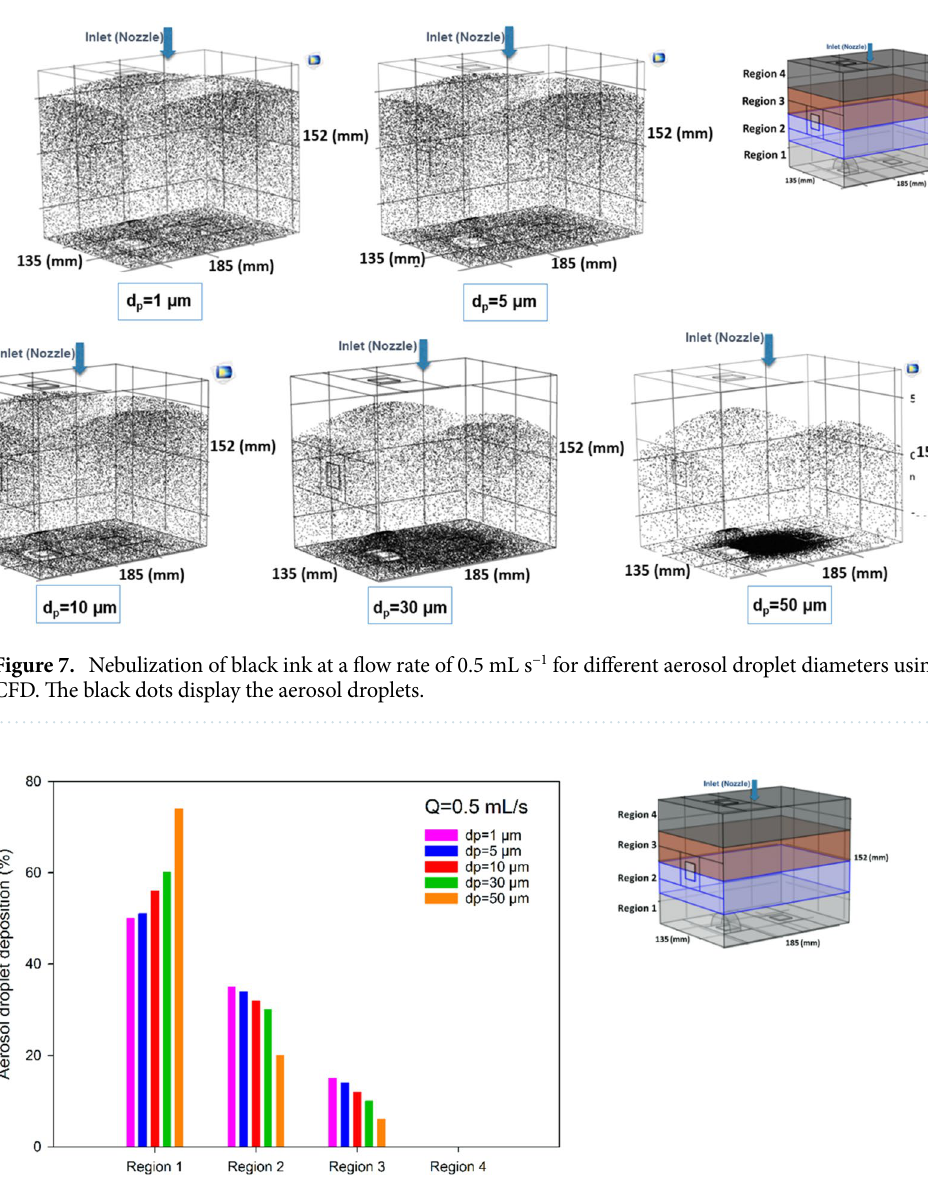
For the analysis of the effect of aerosol droplet size, the CFD modelled box was divided in four regions, cor- responding to dorsal (region 1) to ventral (region 4) regions of the peritoneal cavity. Five different aerosol droplet diameters were modelled (see Fig. 7). The simulations showed that aerosol droplet deposition is significantly affected by their diameter. As shown in Fig. 7, the effect of gravity is quite significant for droplets in the range of 30–50 µm. For smaller droplets, gravity has only a small effect on the deposition pattern. Figure 8 shows the simulated deposition of aerosol droplets, according to diameter, in the four defined regions. With increasing diameter, most droplets deposited in the dorsal region (region 1). With a diameter of 30 µm, 60% of the aerosol droplets deposited in region 1, 30% in region 2, 10% in region 3, and none in region 4. With a diameter of 50 µm, 78% of aerosol droplets deposited in region 1. The results showed that a droplet diameter ranging between 1 and 5 µm resulted in the most homogenous spatial distribution, although coverage of the most ventral region (region 4) remained virtually absent with this flow rate, due to less perturbation of aerosols. More perturbation in the aerosol droplet flow results a better distribution. Effect of liquid flow rate. Fixed droplet diameter. Figure 9A,B compare the deposition of the aerosol droplets with different flow rates in four regions of the box using CFD simulations. In these comparisons, the simulation was done for two different diameters, while all other properties except flow rate of the nebulization